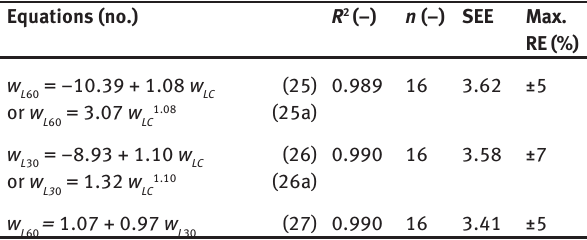
Table 4: Linear and power regression models of relationships between the liquid limit w determined by Casagrande method and L fall cone methods for Eemian